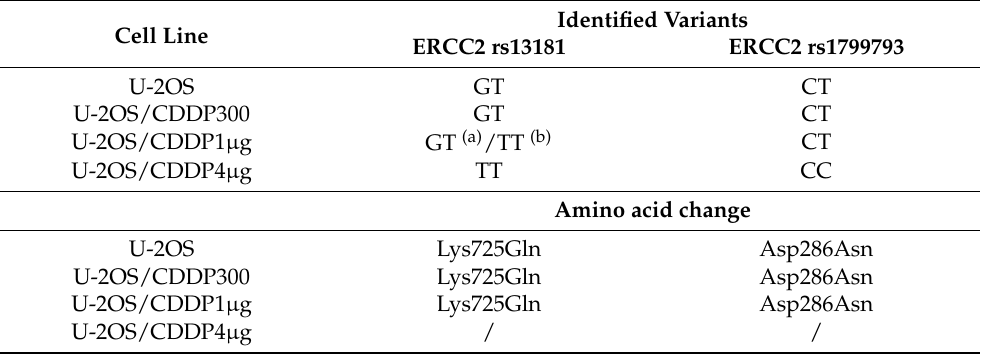
Table 2. DNA single nucleotide polymorphisms with genotype and amino acid changes in U- 2OS cisplatin (CDDP)-resistant variants compared to their parental cell line. Where not differently indicated, genotypes were identified by both multimodal targeted next generation sequencing (mmNGS) and TaqMan genotyping.